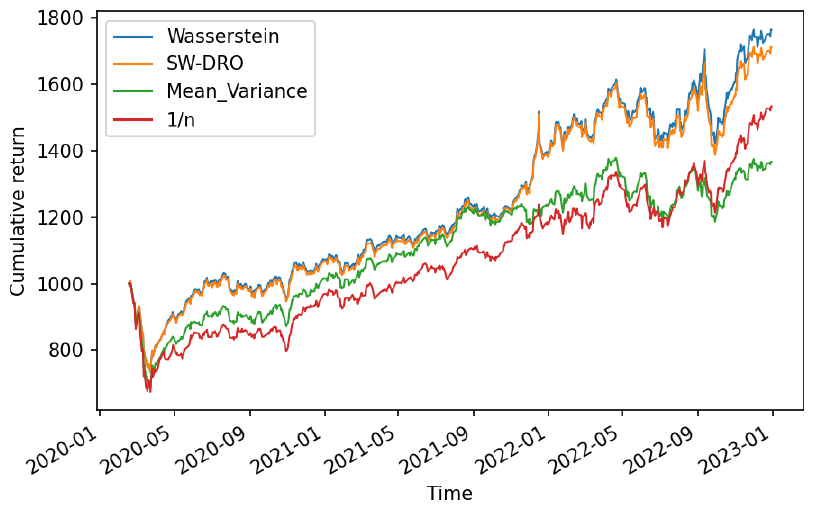
Figure 3. Cumulative return curves under different